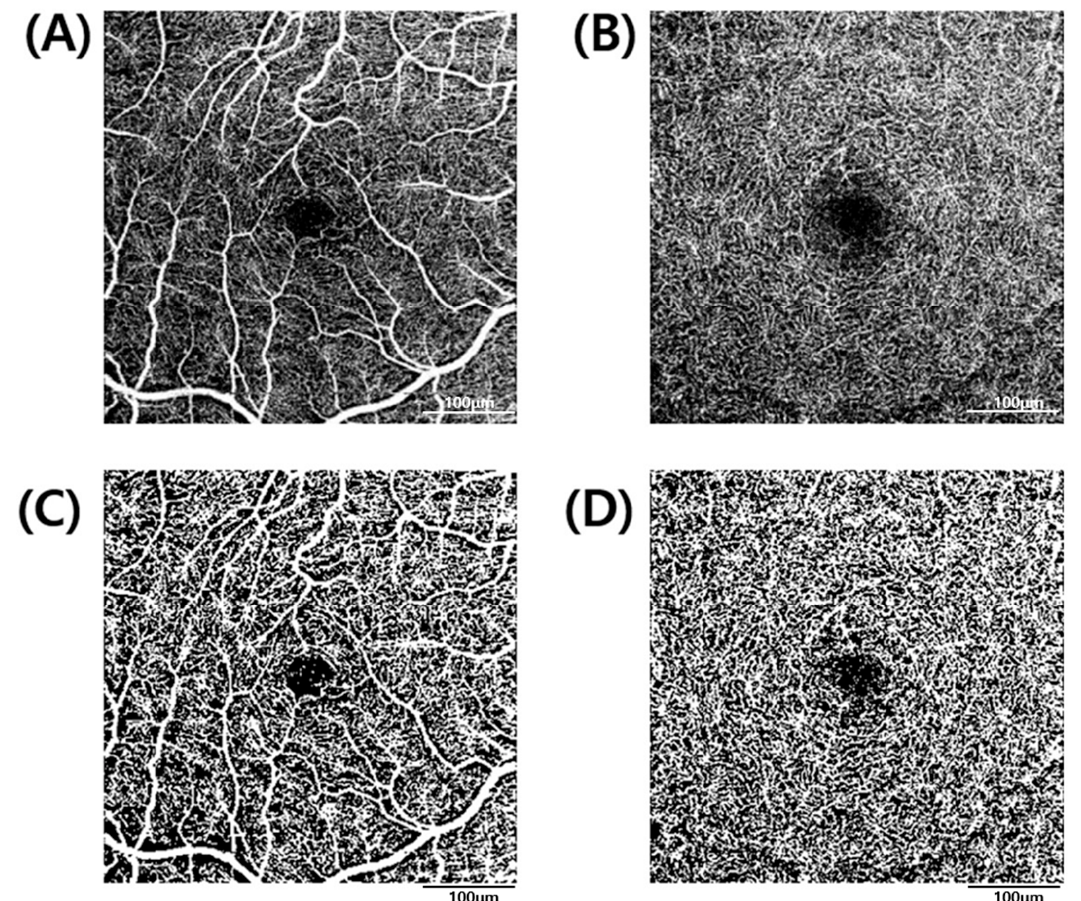
Figure 2. Measurement of the vascular density of the superficial and deep retinal layer. ( A ) Superficial retinal layer angiogram. ( B ) Deep retinal layer angiogram. ( C ) Binarization of the superficial retinal layer using “Phansalkar local thresholding.” ( D ) Binarization of the deep retinal layer using “Phansalkar local thresholding”.